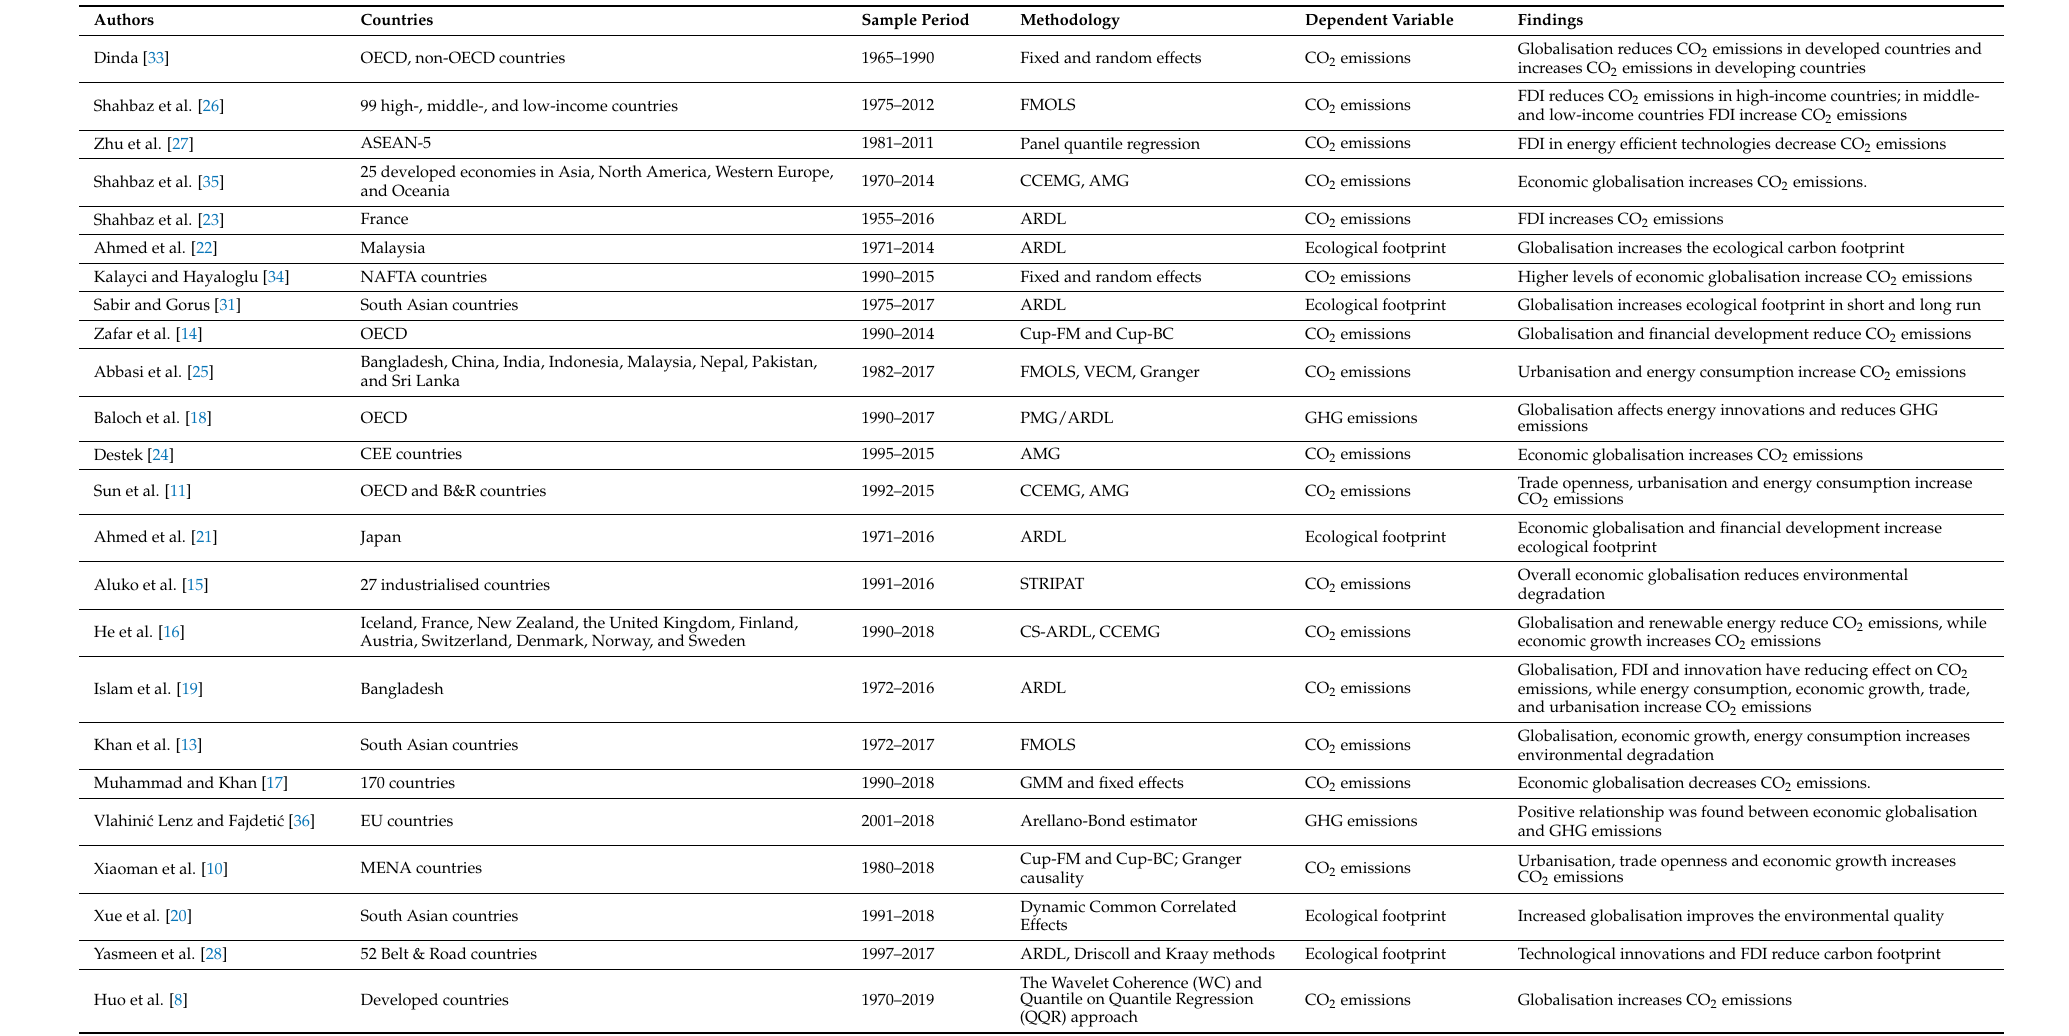
Table 1. Literature review. Source: